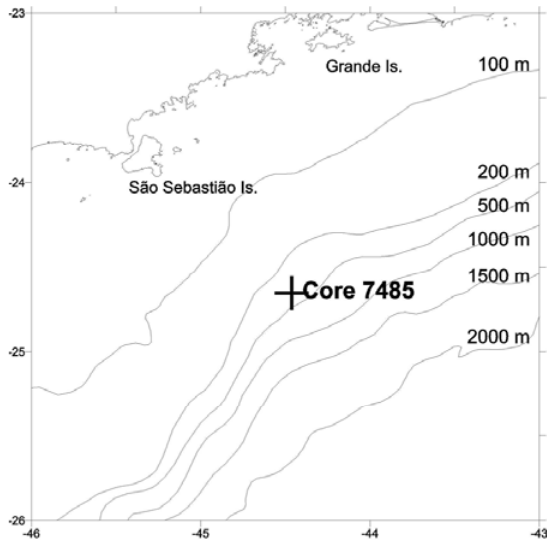
Fig. 1 – Location of the core studied in this